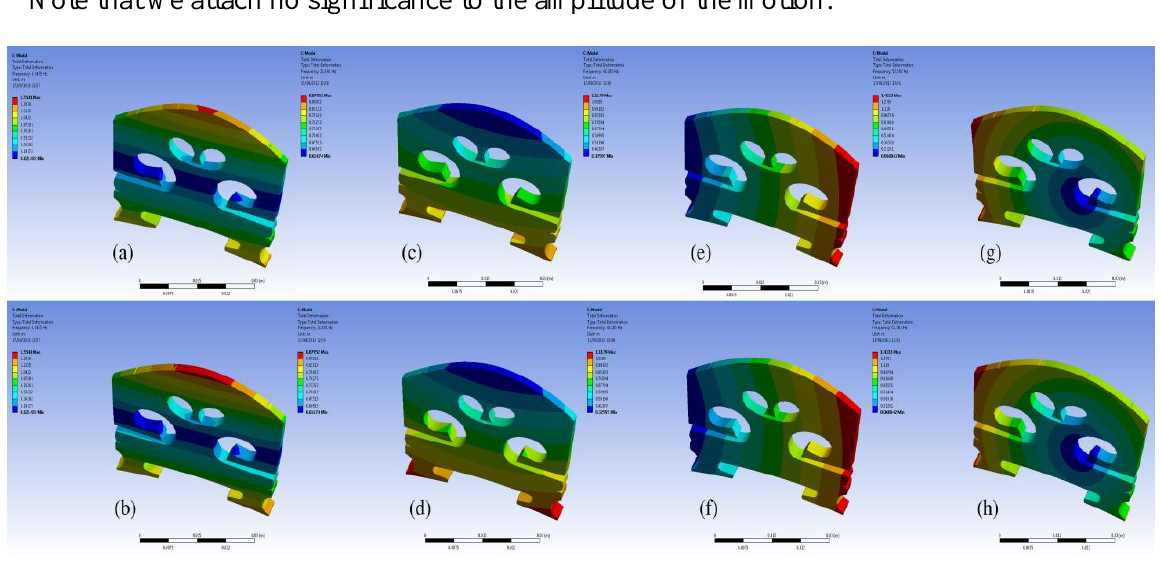
Figure 8. Bridge motion of the four lower frequency resonance modes at 6 Hz ( a , b ), 14 Hz ( c , d ), 41 Hz ( e , f ), and 46 Hz ( g , h ) in the case of EFS1 = 0.001 N/mm 3 in Table 3. Note that we attach no significance to the amplitude of the